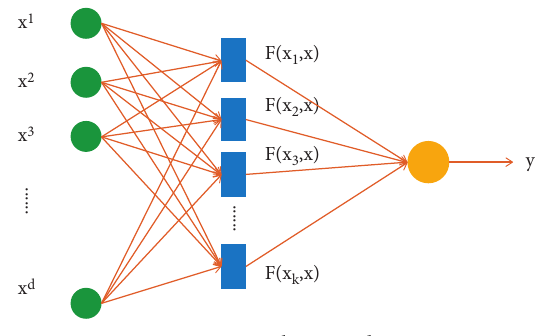
Figure 5: SVM schematic